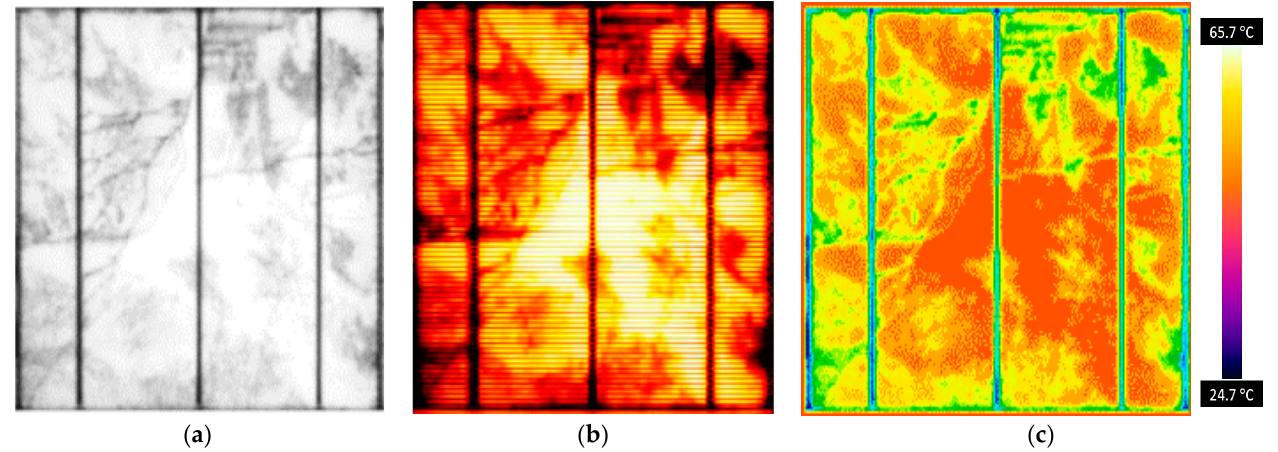
Figure 10. Solar cell inspected under three different industrial inspection methods: ( a ) EL, ( b ) PL, ( c ) thermal.